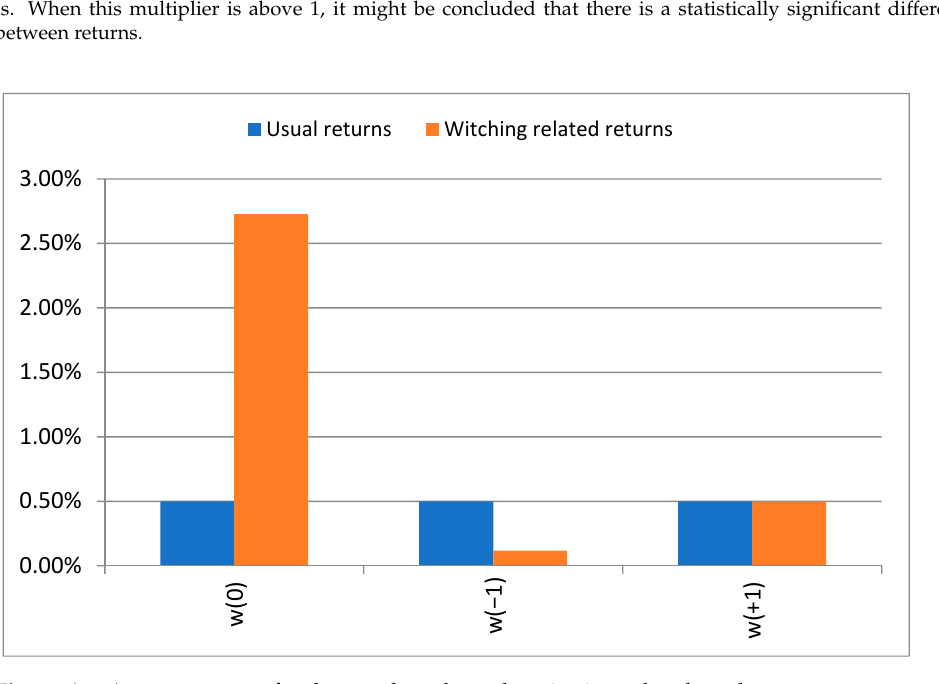
Figure A2. Average returns for the usual weeks and expiration-related weeks. Table A8. ANOVA test of the expiration price effects.